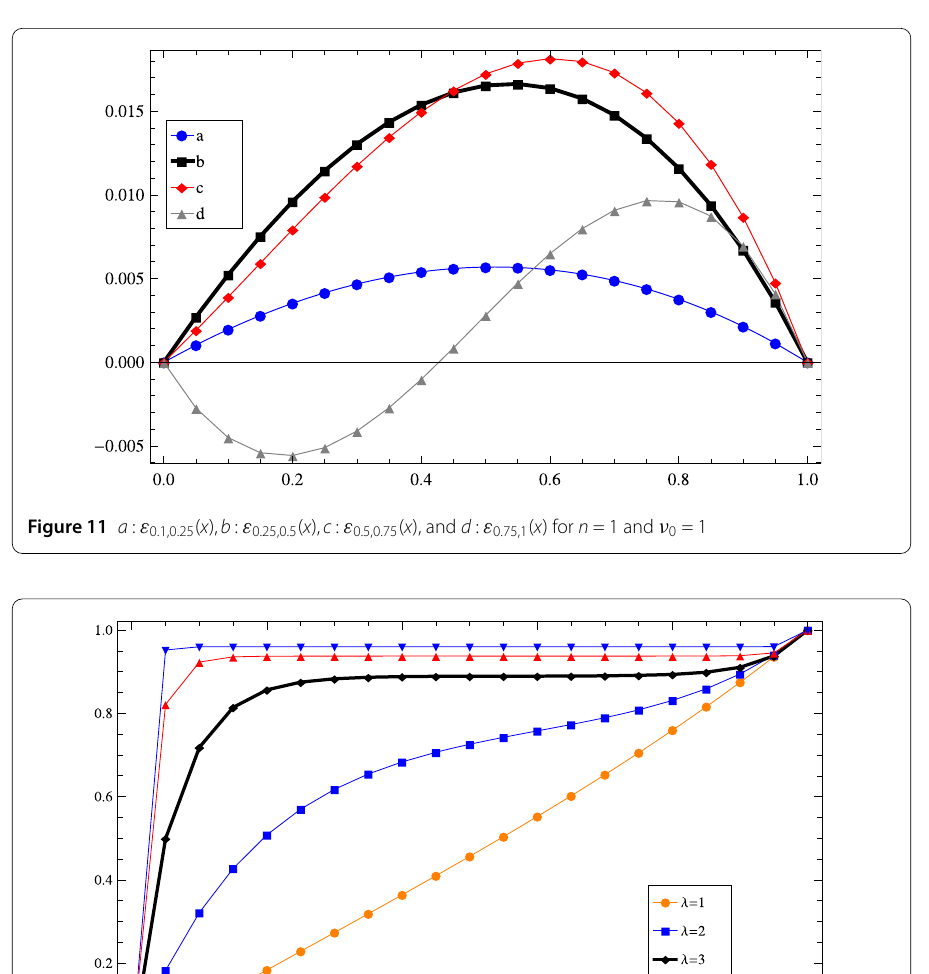
tion technique (LT-MDM) [11] are reported for Troesch parameters λ = 0.5 and 1. Table 8 contains absolute errors of numerical solutions evaluated by approach III, sinc-Galerkin method based upon double exponential transformation (DESG) [13], and B-SCM [25] for λ = 5. For having a comparison between the results of presented methods, L 2 -errors of numerical solutions are given in Table 9, where L 2 -error is defined as follows. Suppose that ν and ν ∗ are the exact and numerical solutions of problem (1), respectively, we put j ν ( x ν ∗ ( x (cid:24) , j = j ) – j ), j = 0,1,..., N , x j = 10